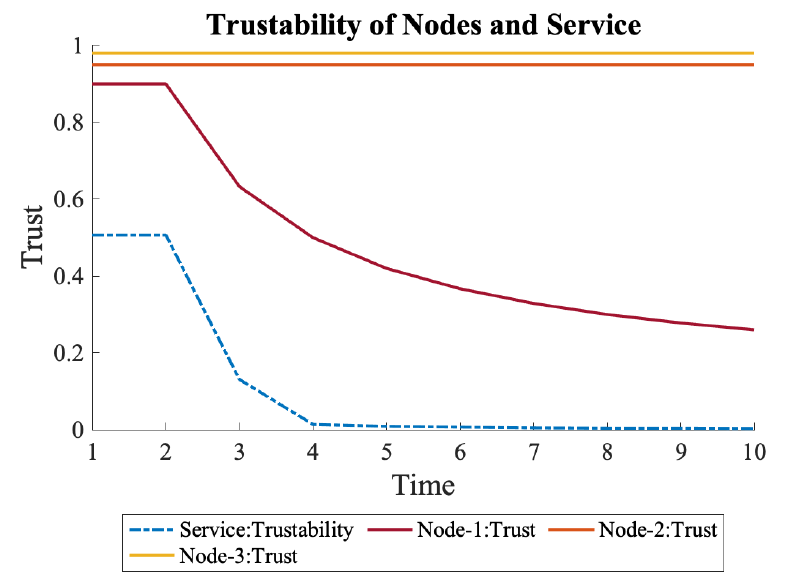
Figure 13. A sudden drop in trust measurements causes a continuous decline in the trust of N1. This reflects a more dramatic decline in the overall trustability of the service.